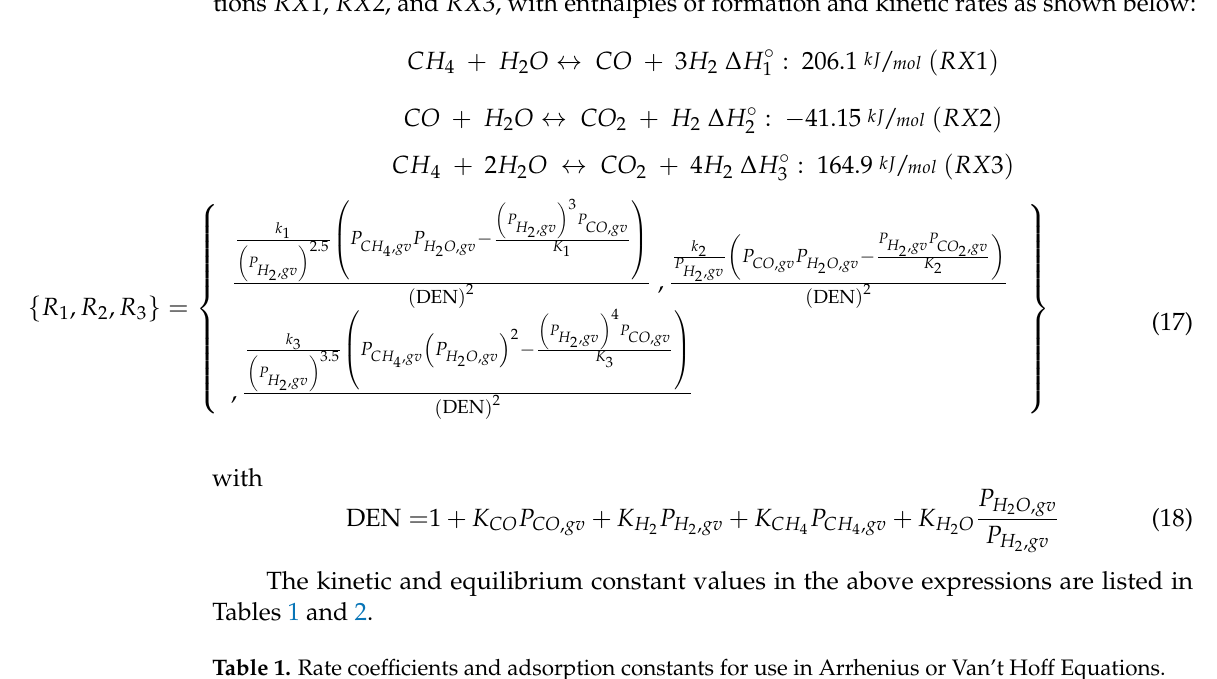
Table 1. Rate coefficients and adsorption constants for use in Arrhenius or Van’t Hoff Equations. Rate Coefficient or